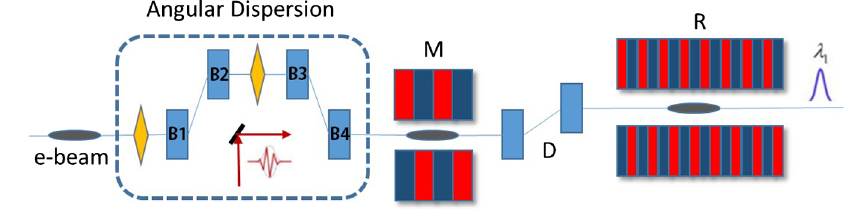
FIG. 1. Layout of our proposed